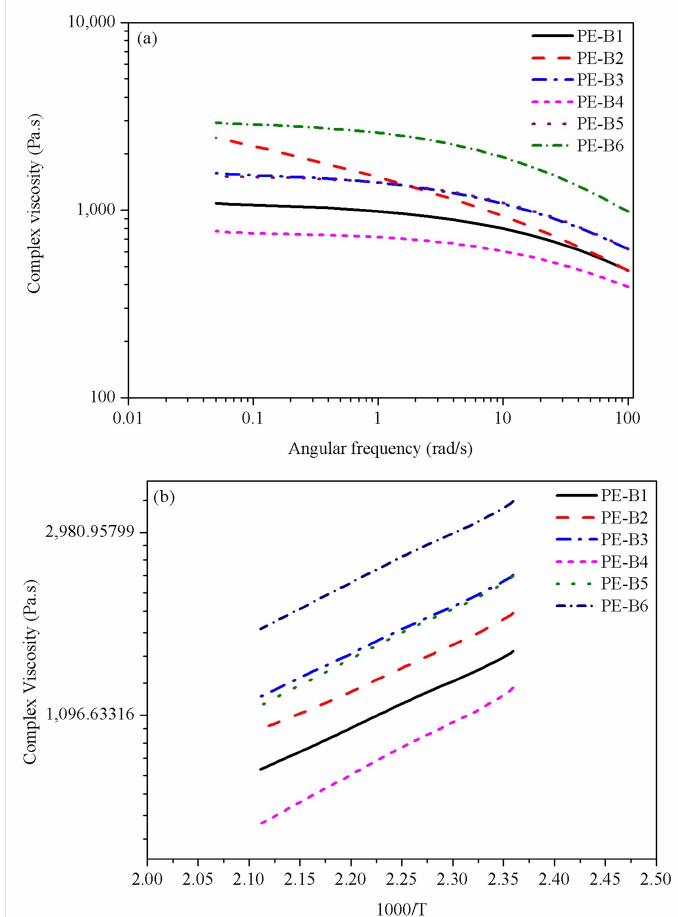
Figure 3. ( a ) Viscosity-frequency curves of samples; ( b ) Viscosity-temperature curves of samples.